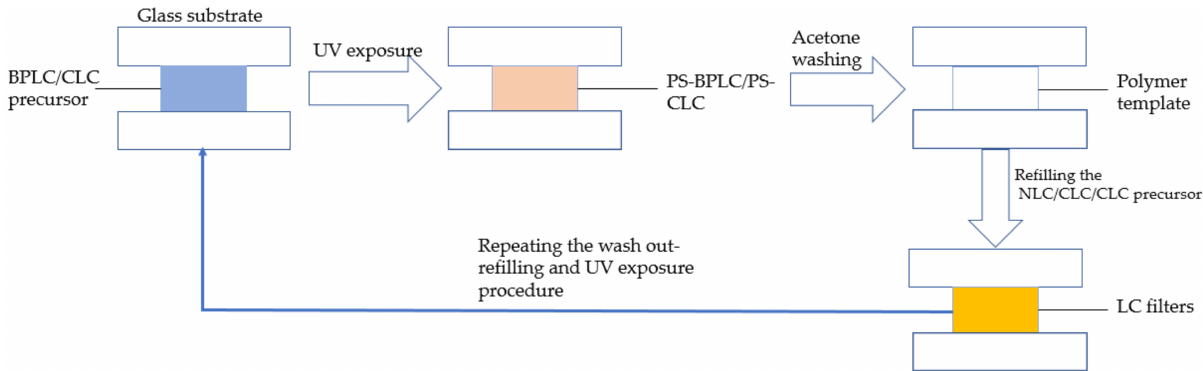
Figure 3. The surface morphology of ( a ) PS-CLC and ( b ) T-CLC.